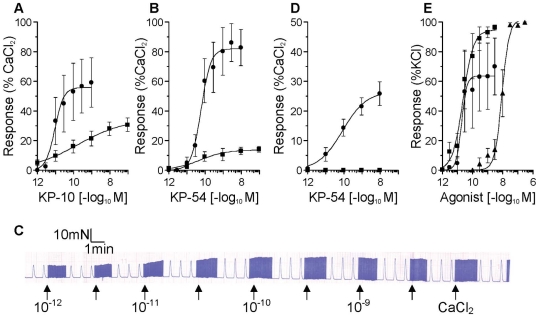
Functional responses to kisspeptins in human, rat and mouse cardiovascular tissues.Concentration-response curves showing positive inotropic effects of (A) KP-10 and (B) KP-54 on strips of human atrial appendage (•) and rat atria (▪). An example of the chart recorder trace for a single human atrial strip is shown (C). The chart recorder speed was increased before the addition of each concentration of kisspeptin to allow analysis of lusitropic responses (half time to peak force and half time to relaxation) for individual peaks. (D) Concentration-response curves showing the positive inotropic effect of KP-54 on Kiss1r
+/+ mouse atria (•) and lack of effect on Kiss1r
−/− atria (▪). (E) Vasoconstrictor responses to KP-10 (•), KP-54 (▪) and ET-1 (▴) in endothelium-denuded rat aortic rings. All values are mean ±SEM.